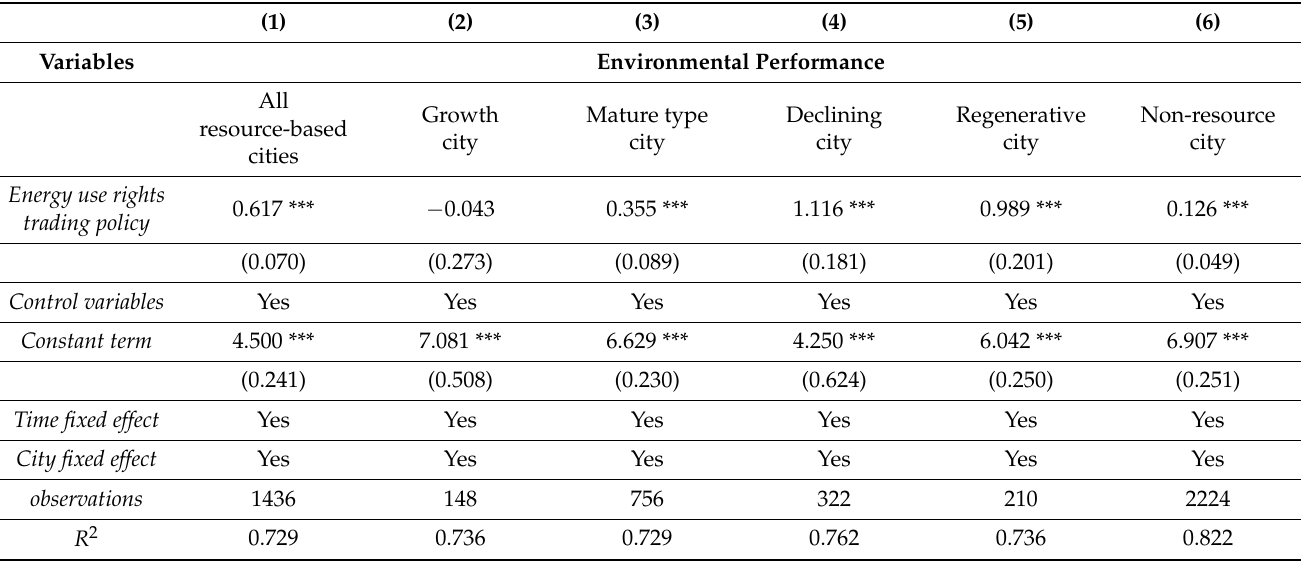
Table 4. Heterogeneity test of different resource-based